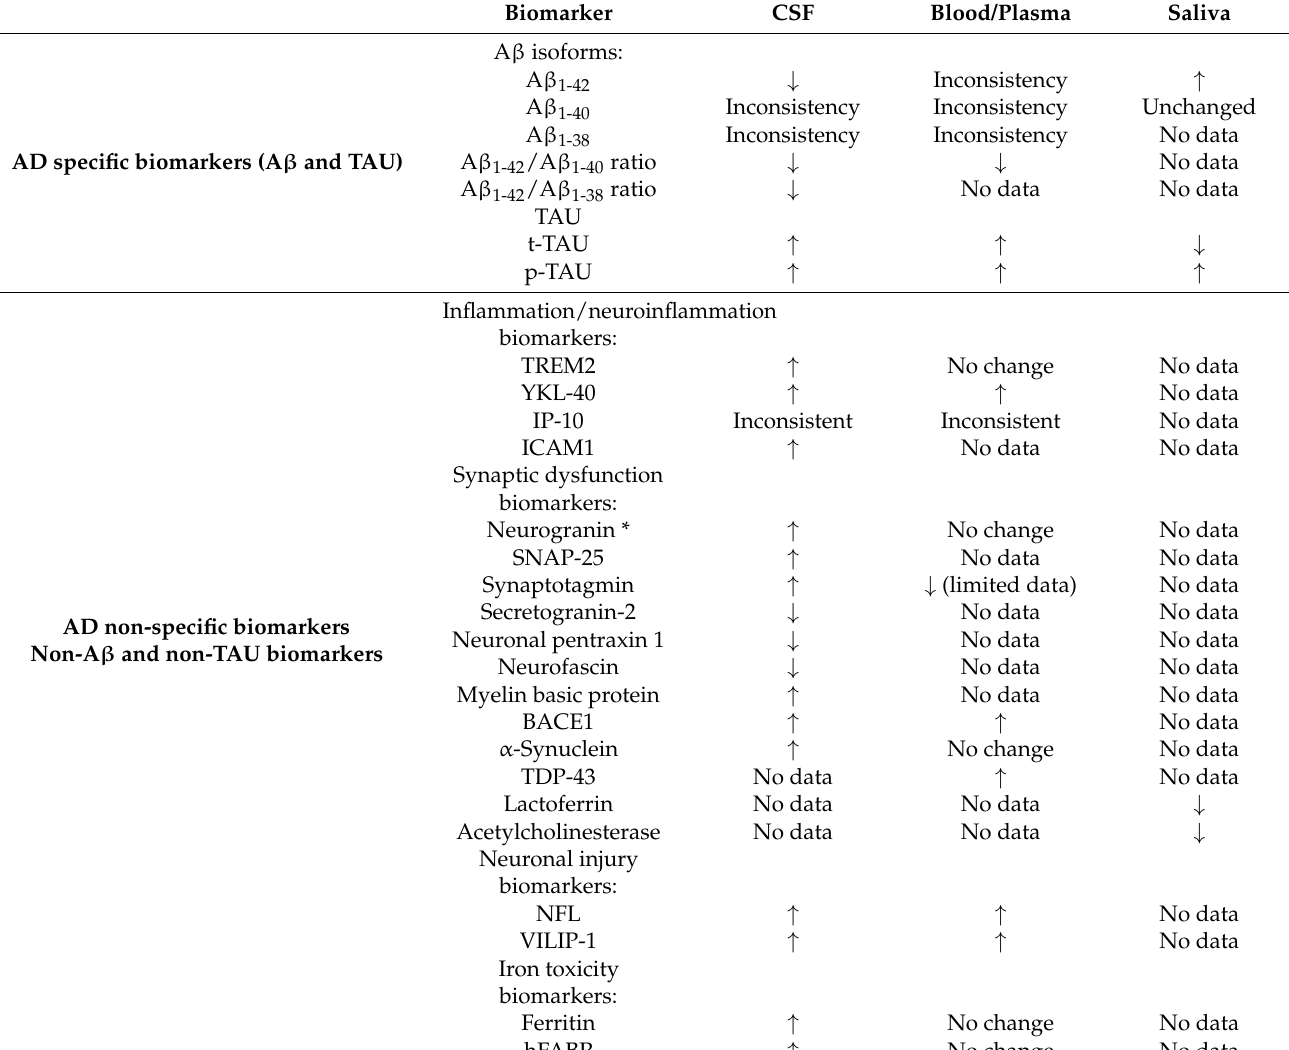
Table 2. Detailed presentation of both AD biomarkers and candidate biomarkers and their levels comparison between CSF, blood and saliva.